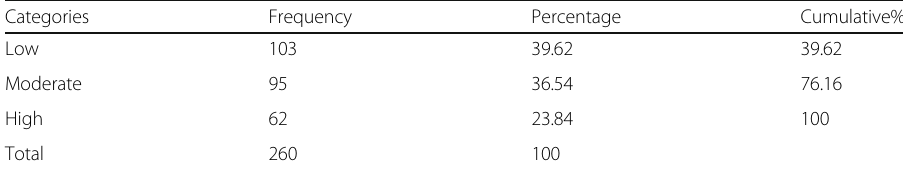
Table 1 Distribution of the three categories of avocado